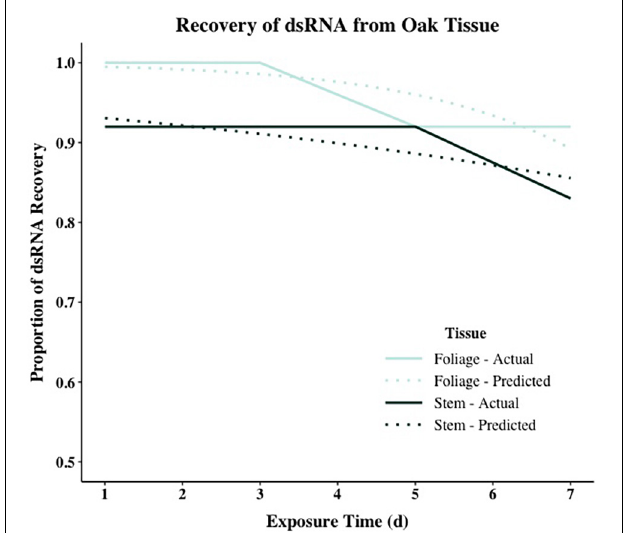
FIGURE 3 | Logistic regression models showing dsRNA recovery in dsGFP-treated foliage and stem tissues of oak seedling across replicates showing actual (solid lines) and projected probabilities (dotted lines). Refer to Table 5 for model statistics.